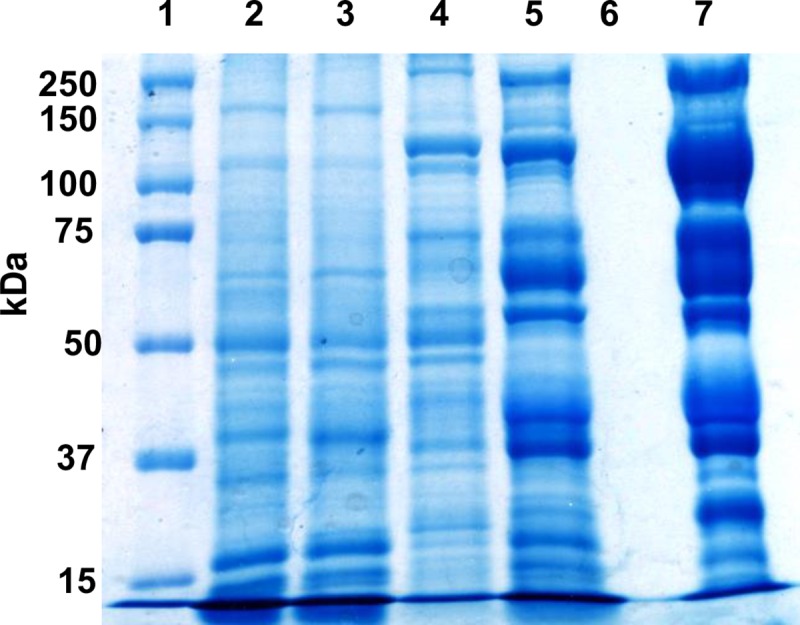
Representative SDS gel electrophoresis of proteins extracted from fresh and frozen-thawed bull sperm, cholesterol-cyclodextrin tris-glycerol (CC2+TG7%) extender and tris-egg yolk-glycerol (TEYG control) extender.Lane distribution: 1, Markers; 2, Fresh sperm; 3, Frozen sperm-CC2+TG7%; 4, Frozen sperm-TEYG-PW; 5, Frozen sperm-TEYG-CW; 6, CC2+TG7% extender per se; and 7, TEYG control extender per se. Lanes 2–5 and 7 contained 15 μg protein extract, lane 6 contained plain CC+TG extender (equivalent to the volume of TEYG extender used in lane 7).